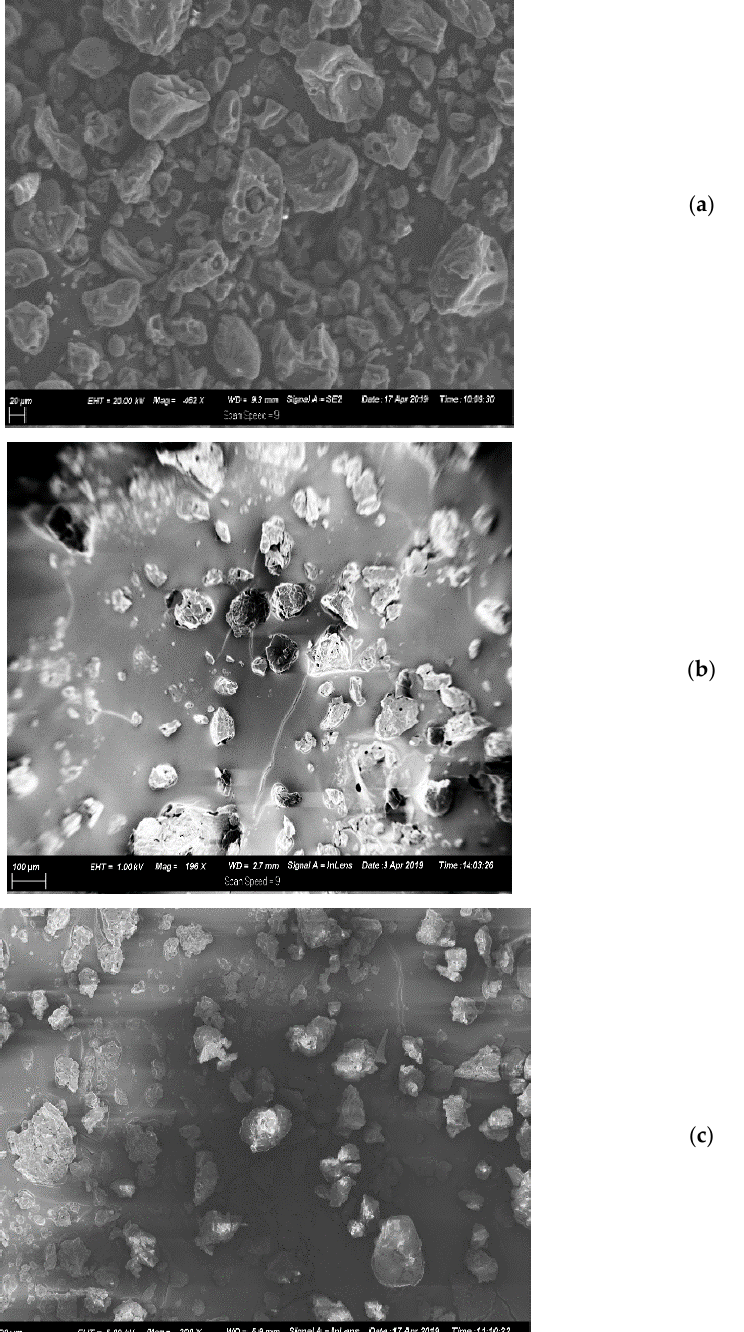
Figure 1. Morphology of A. mearnsii tannin particles viewed using SEM ( a ) unencapsulated mimosa tannin, UMT, ( b ) encapsulated mimosa tannin in palm oil, EMT P and ( c ) encapsulated mimosa tannin in sunflower oil, EMT S .